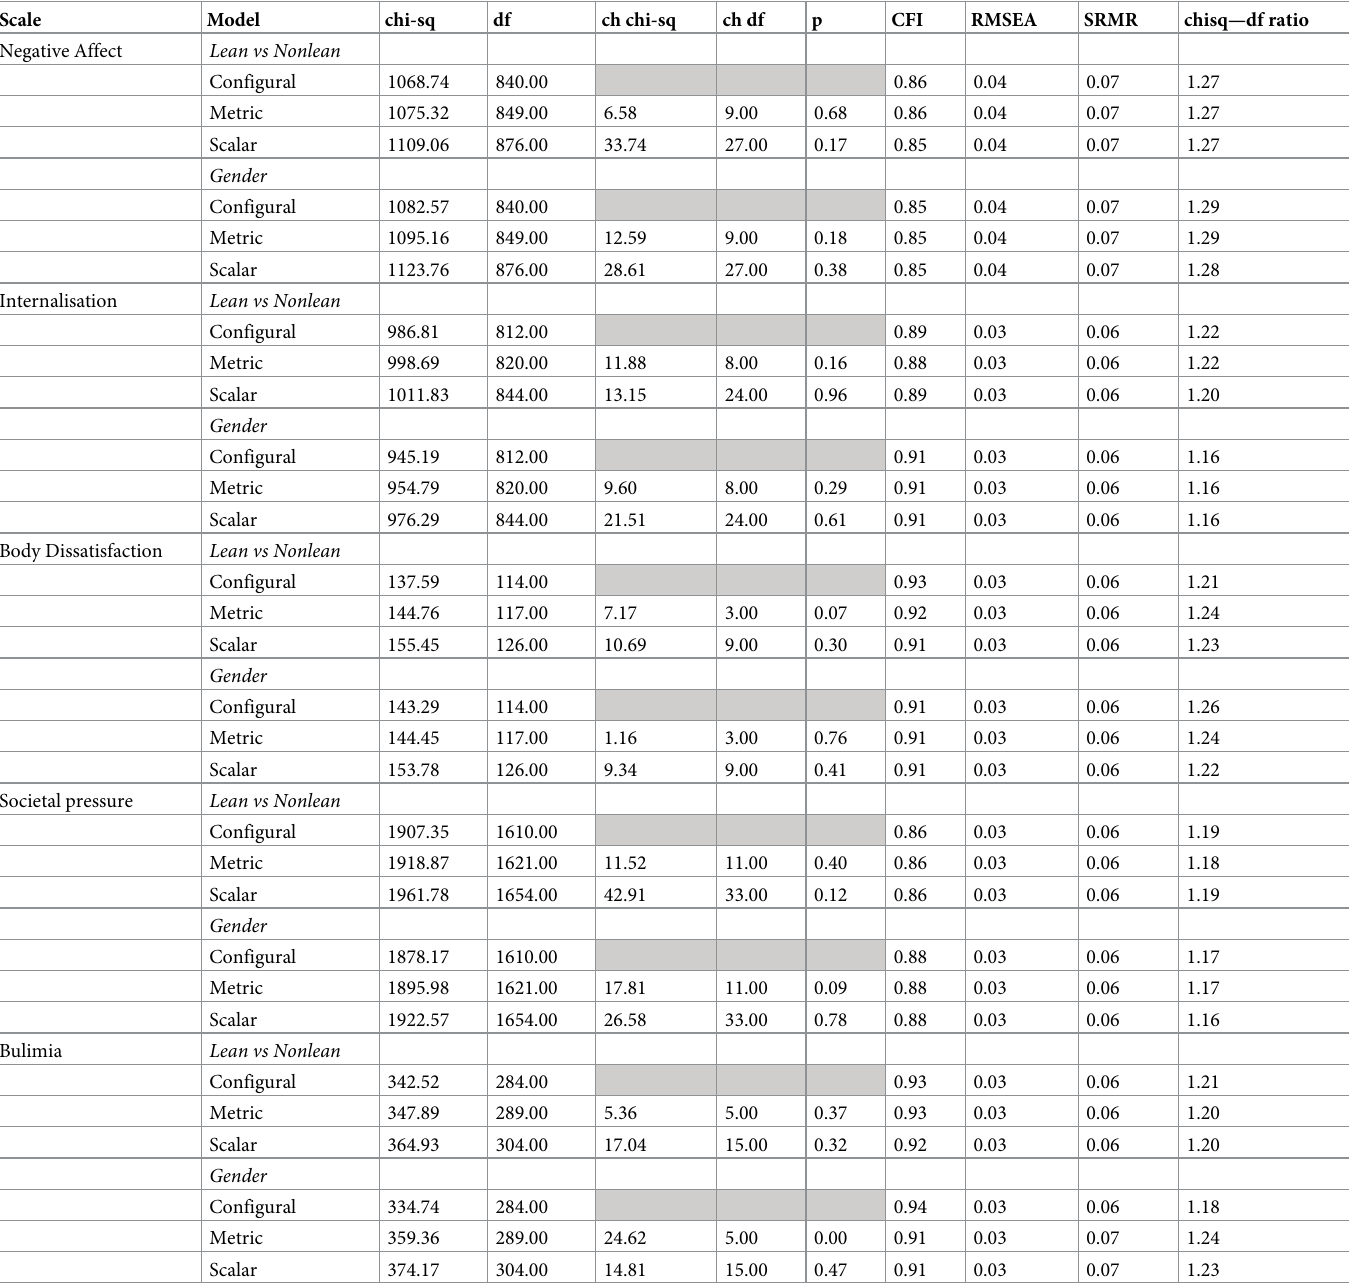
Table 5. Group Invariance for gender and